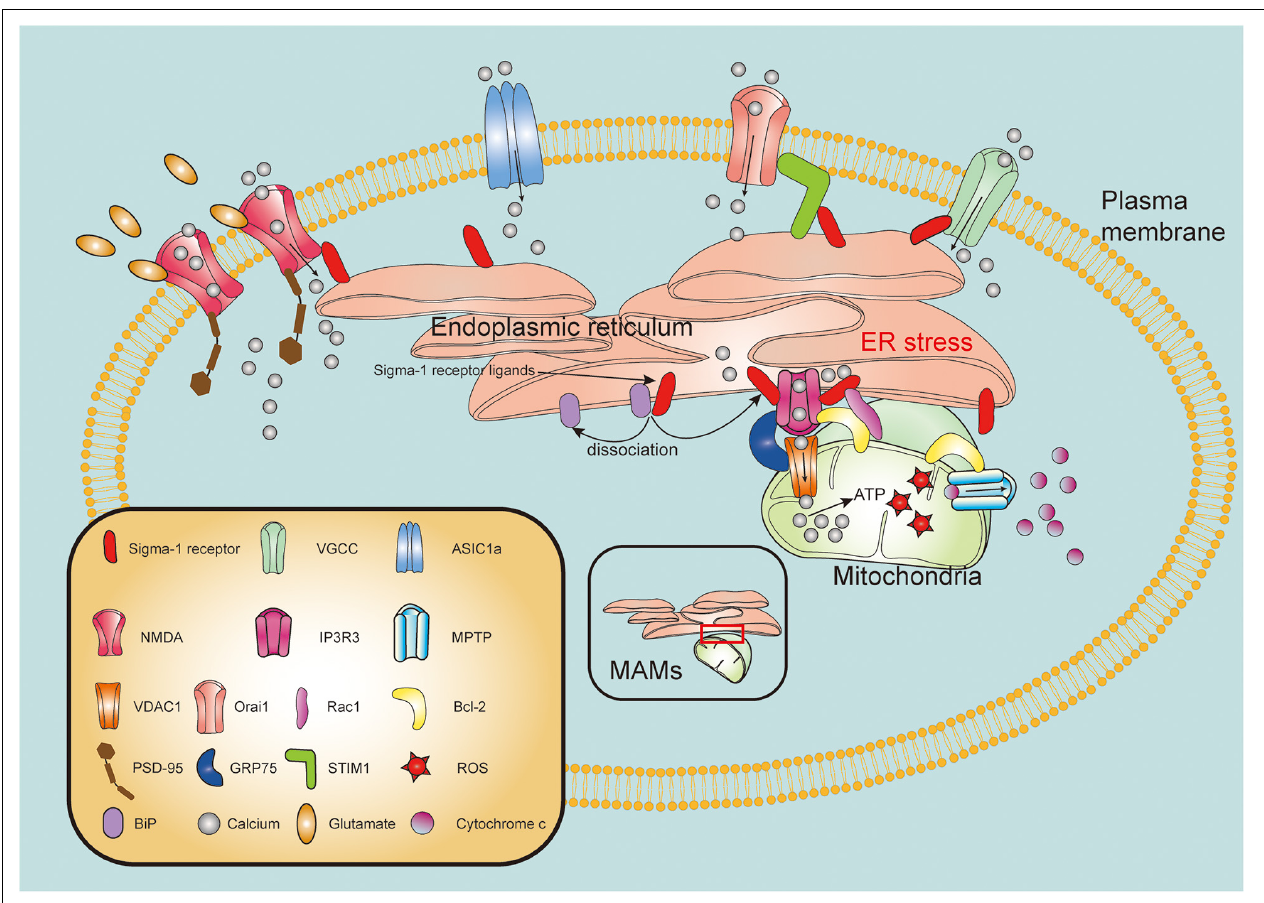
FIGURE 2 | Molecular mechanisms of sigma-1 receptor in modulation of mitochondrial function and intracellular calcium homeostasis. Upon the ER stress or agonist stimulation, sigma-1 receptor (Sig-1R) dissociates from binding immunoglobulin protein (BiP) and binds to type 3 inositol 1,4,5-trisphosphate receptor (IP3R3), mainly resides at the mitochondria-associated membranes (MAMs). IP3R3s forms a tripartite complex with voltage-dependent anion-selective channel (VDAC) and glucose-regulated protein 75 (GRP75) to connect the ER and the mitochondria. Sig-1R activation facilitates calcium transfer from endoplasmic reticulum (ER) to mitochondria through IP3R3-GRP75-VDAC1 channel. Excessive ROS production promotes mitochondrial permeability transition pore (MPTP) opening, leading to release of cytochrome c from mitochondria to cytosol. Sig-1R may directly form a complex with IP3R, Bcl-2 and Ras-related C3 botulinum toxin substrate 1 (Rac1). Furthermore, Sig-1R can translocate from MAMs to plasma membrane where it directly or indirectly modulates intracellular calcium homeostasis by regulating activities of various plasma membrane elements including N-methyl-D-aspartate receptors (NMDARs), voltage-gated calcium channels (VGCCs), acid-sensing ion channel a (ASIC1a) and stromal interaction molecules 1 (STIM1)/Orai1